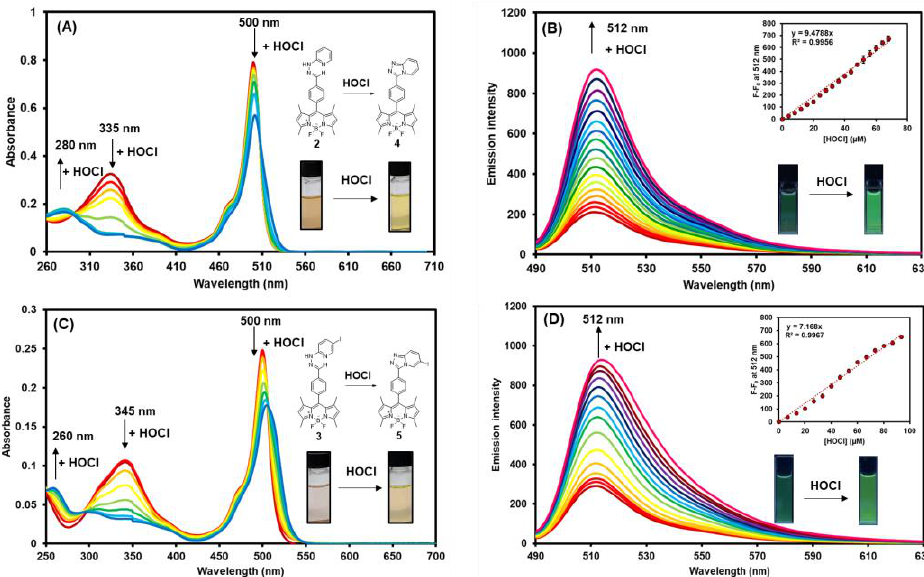
Figure 4. The changes in the absorption spectra of compound 2 ( A ) and compound 3 ( C ), and the changes in emission spectra of compound 2 ( B ) and compound 3 ( D ) (excitation wavelength = 475 nm) in the presence of various concentrations of HOCl in MeOH-5mM PBS (1:1 v/v ) (final concentrations of BODIPY compounds = 0.2 µM). Error bars represent standard deviation ( n = 3). Table 1. Photophysical properties of compounds 2 - 5 in MeOH-5mM PBS (1:1 v/v ). Cpd.